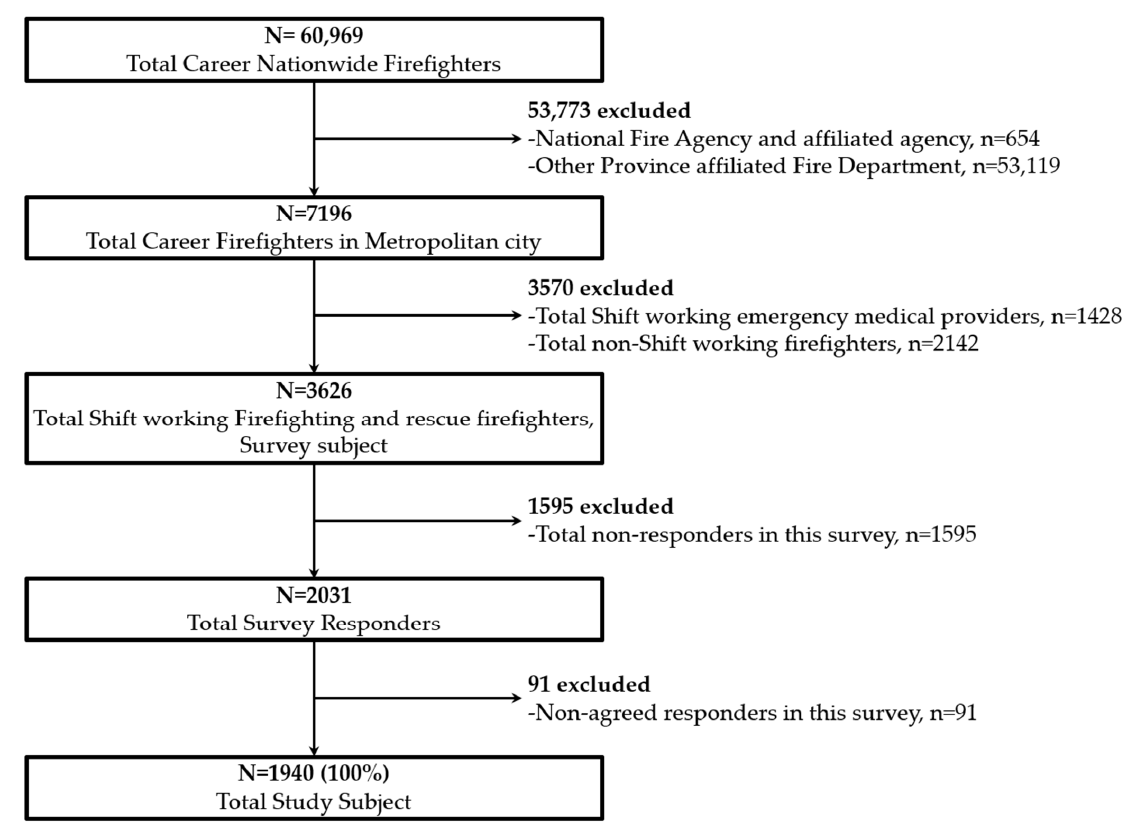
Figure 1. Inclusion